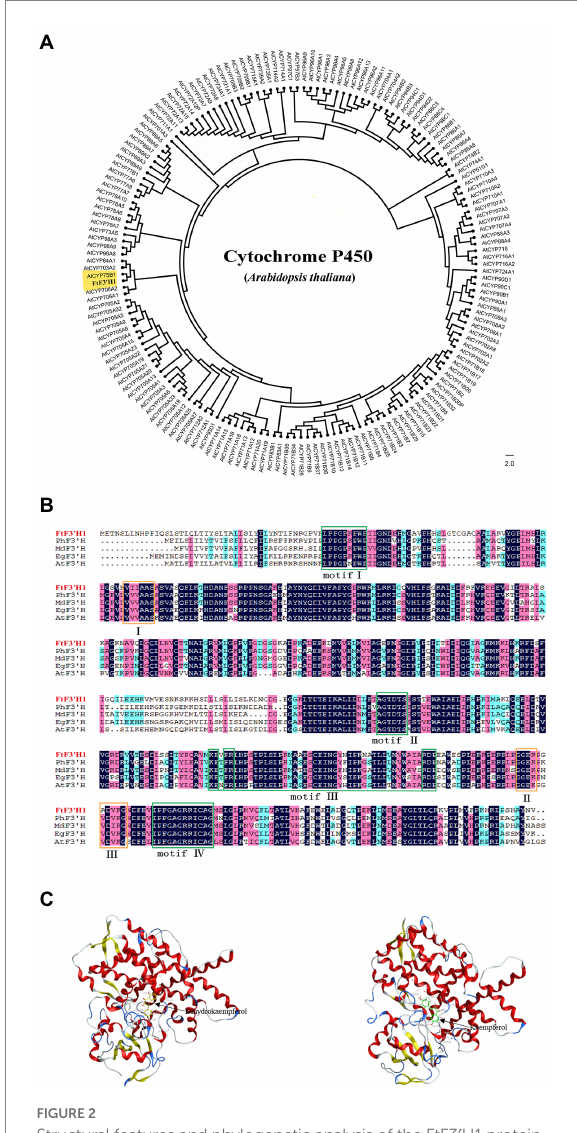
FIGURE 2 Structural features and phylogenetic analysis of the FtF3 ′ H1 protein. (A) Molecular phylogenetic tree of F3 ′ H proteins by the maximum likelihood method. (B) Sequence alignment of the deduced FtF3 ′ H1 with F3 ′ H proteins from other species, motifI (PPGPTPWP), motifII (FGAGRRICAG), motifIII (E-R-R), motifIV (AGTDTS), I (VVVAAS), II (GGEK), III (VDVKG). GenBank accession numbers for the proteins in the alignment are as follows: Petunia (AAD56282.1), Malus (ACR14867.1), Eustoma grandiflorum (BAP94456.1), Arabidopsis thaliana (CAB62611.1). (C) Docking prediction for FtF3 ′ H1 protein with Dihydrokaempferol and